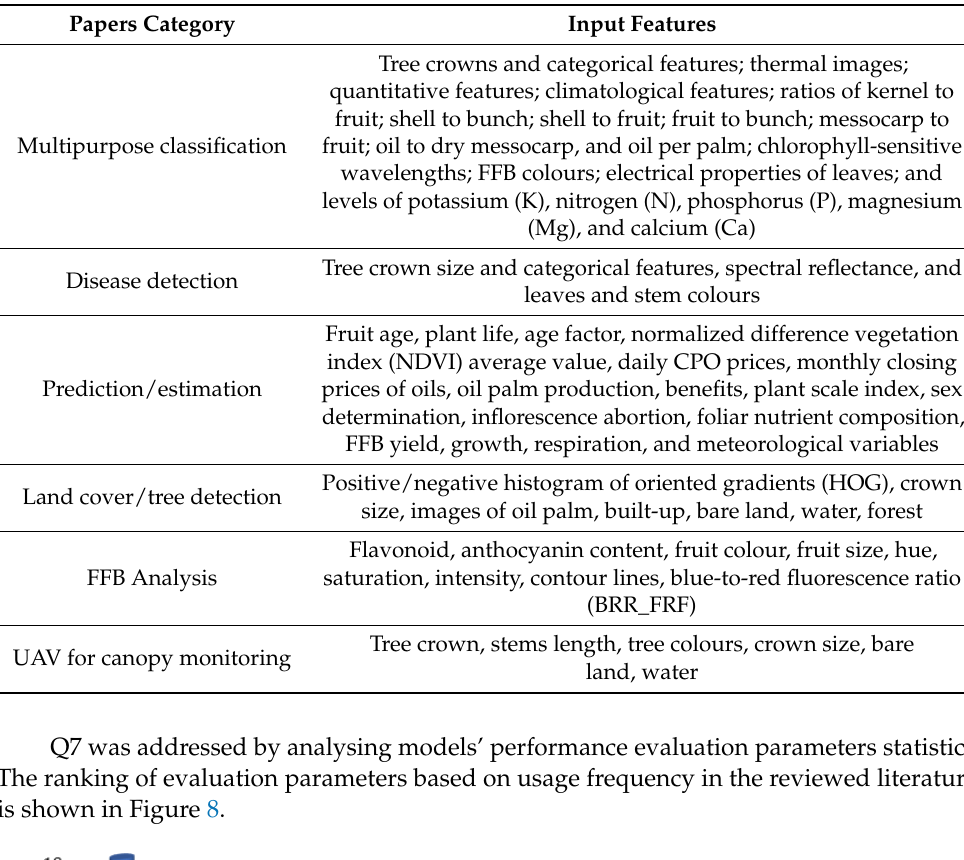
Table 1. Input features.